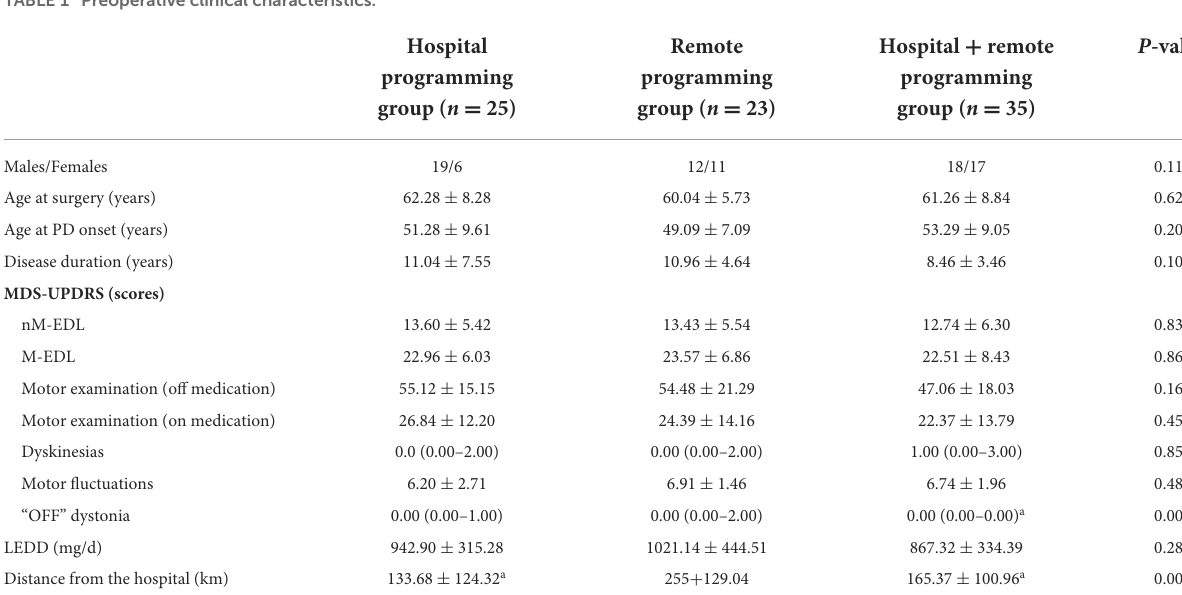
TABLE 1 Preoperative clinical characteristics.